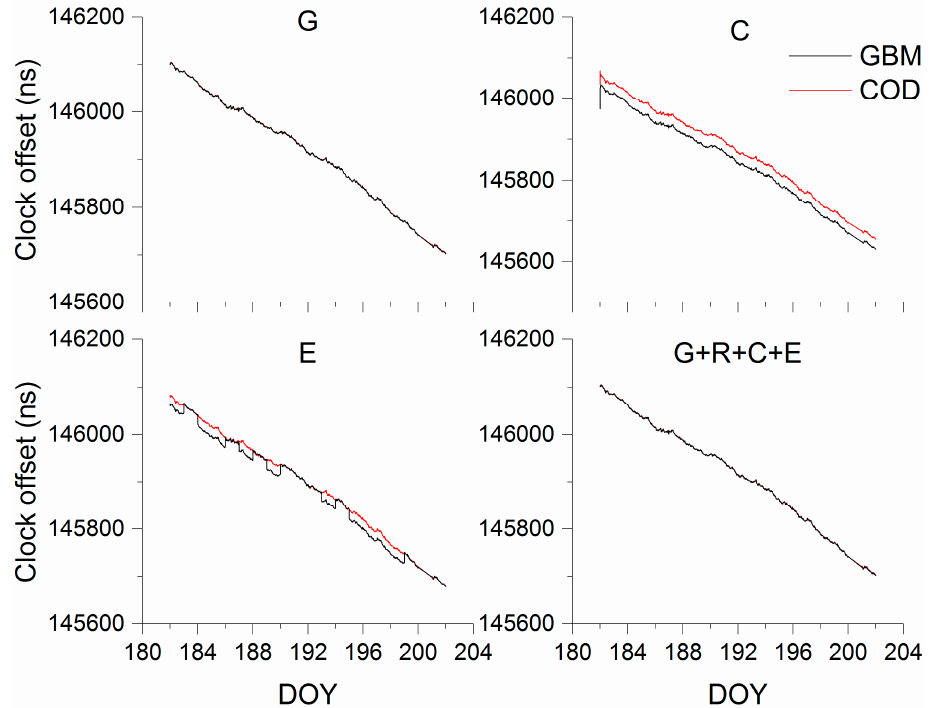
Figure 3. Clock offset in single-system and multi-GNSS models on HARB using COD and GBM products.